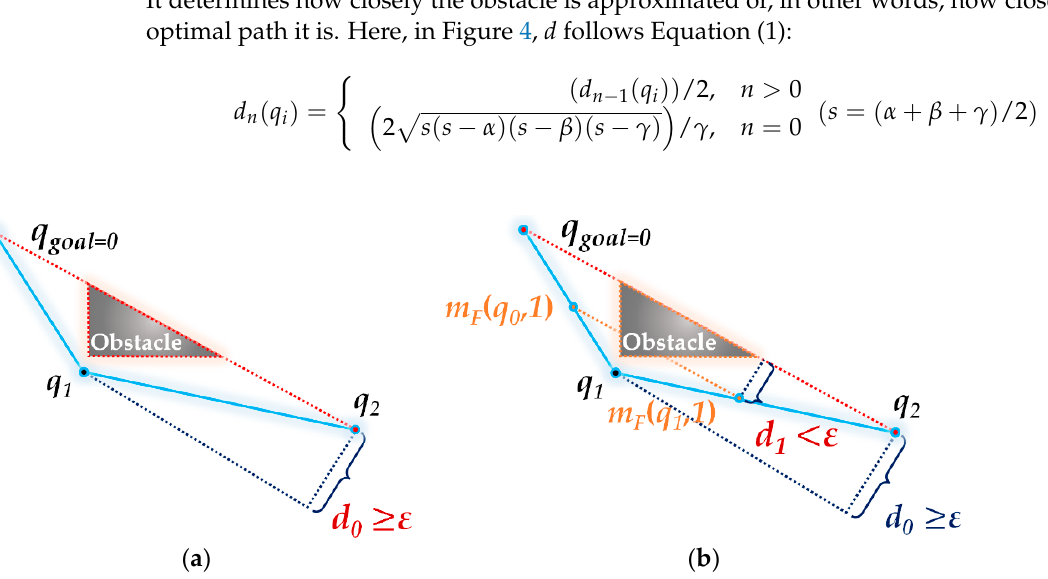
Figure 4. Interpolation function of post triangular processing of the midpoint interpolation method: ( a ) height d 0 of the triangle formed by waypoints q 0 , q 1 , and q 2 of the path is greater than ε (interpolation continuation); ( b ) height d 1 of the triangle formed by midpoints m F ( q 0 ,1) and q 1 of q 0 and q 1 and midpoint m F ( q 0 ,1) is the midpoint of q 0 and q 1 , also m F ( q 1 ,1) is the midpoint of q 1 and q 2 .